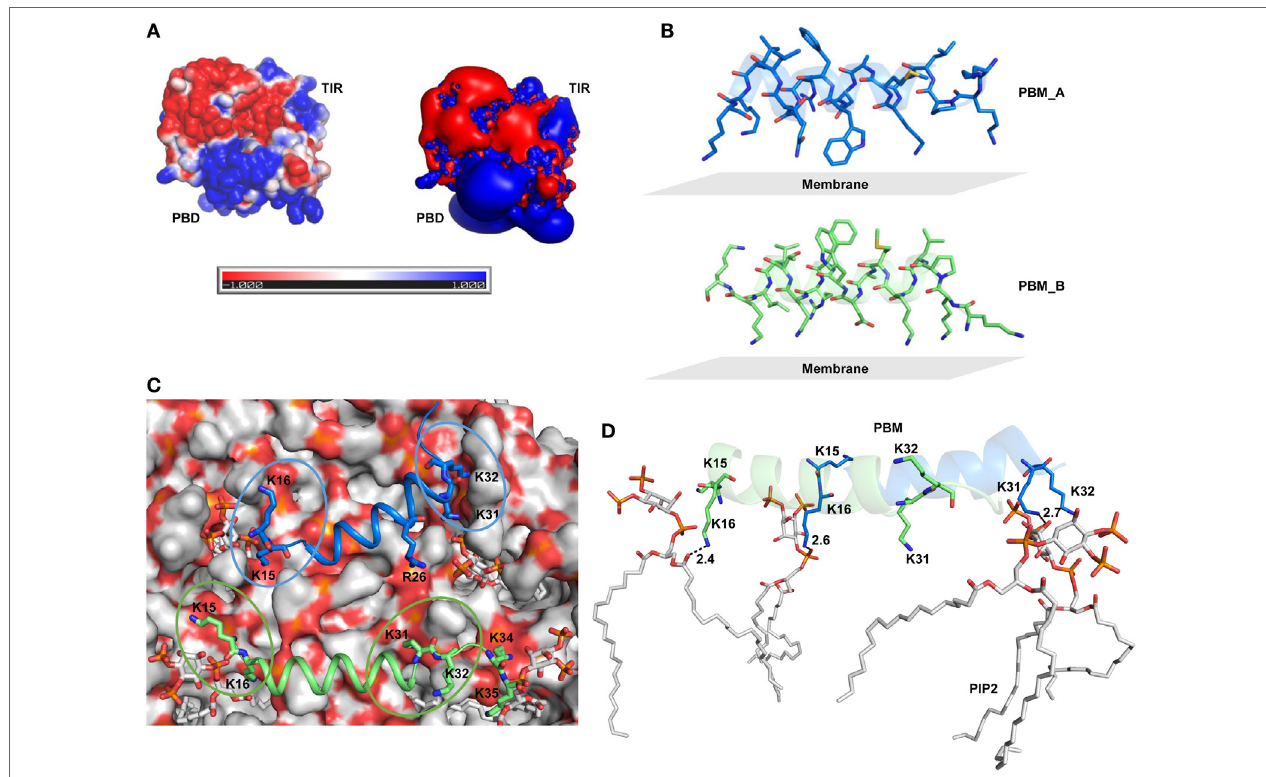
FigUre 5 | Surface electrostatics of toll/interleukin 1 receptor domain-containing adaptor protein (TIRAP) and the location of phosphatidylinositol (PI) 4,5-bisphosphate (PIP2) on the membrane surface. (a) Two different representations of electrostatic potential over TIRAP. The left image shows the positive (blue), negative (red), and neutral (white) surfaces of TIRAP, while the right image represents an electrostatic isosurface, showing only the surface distribution of the most positively and negatively charged residues on TIRAP’s surface. (B) Orientation of the PI-binding motif (PBM) side chains with respect to the membrane surface in the final snapshot after 100 ns of molecular dynamics (MD) simulation. (c) Top view of the membrane surface showing the position of PIP2 and PI-binding residues of TIRAP. (D) Intermolecular interaction between dimeric PBM and four PIP2 molecules at the end of 100 ns of MD simulation. Dashed lines represent hydrogen bonds, and digits indicate distances in angstrom